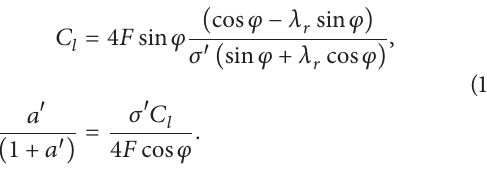
wind loads and structural part to calculate the dynamic response of structure, with time history and spatial distribu- tion of wind as input, Figure